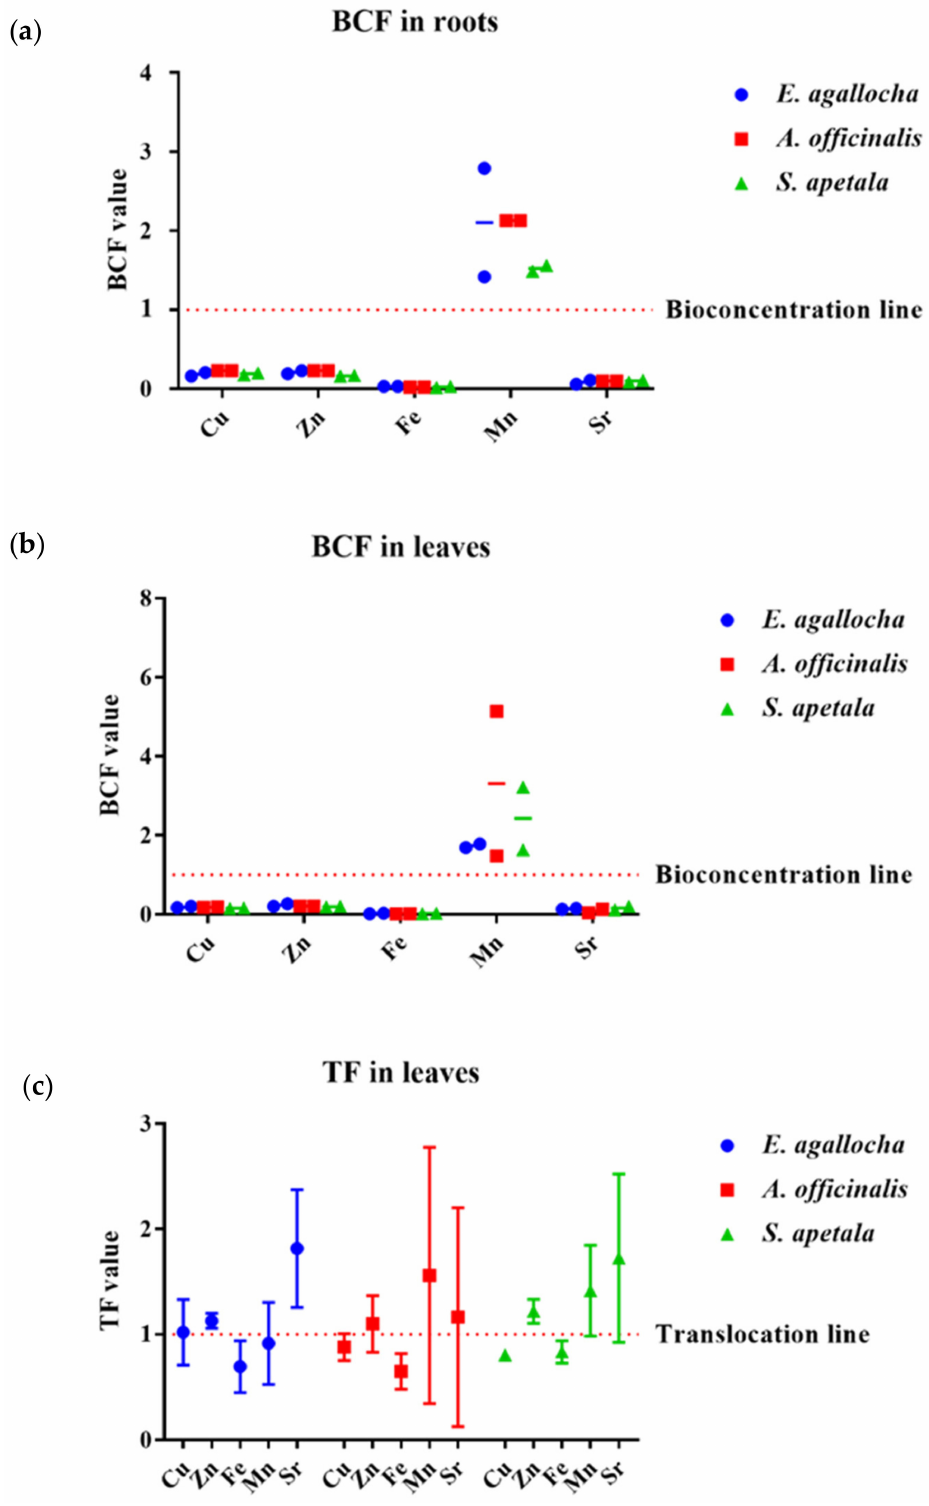
Figure 3. Bioconcentration factor (BCF) in roots ( a ) and leaves ( b ) and translocation factor (TF) estimated ( c ) for the heavy metals in the three mangrove species. BCF and TF were based on the average metal concentration for both stations. The values below the bioconcentration and translocation line indicate the species are less suitable for phytoextraction and translocation of